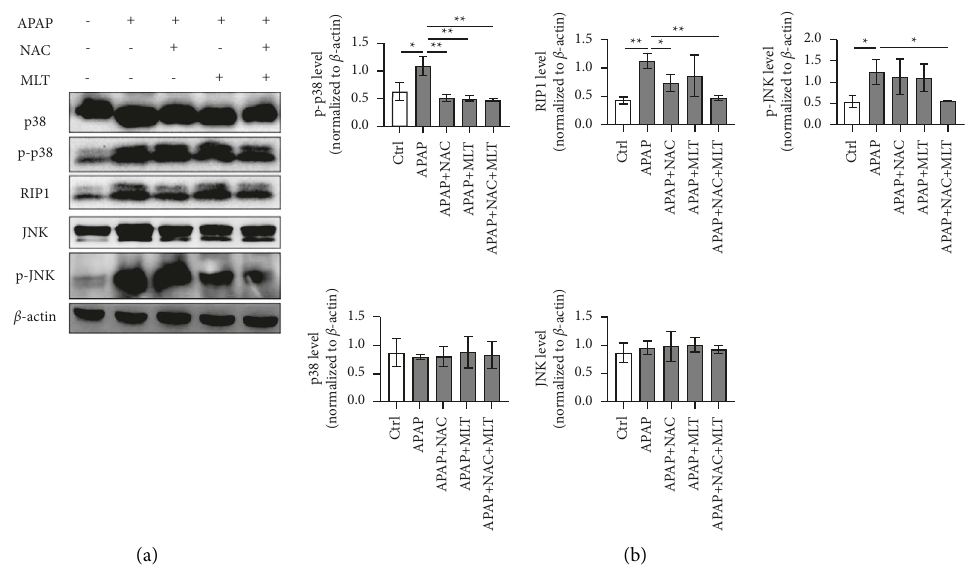
Figure 4: The effect of MLT, NAC, and combined drugs in RIP1/JNK associated apoptosis in APAP-induced liver damage. (a) Repre- sentative binds and (b) statistical grey-value analysis of protein level for each group. The columns are shown as means ± SD ( n � 3). ( ∗ p < 0 . 05, ∗∗ p < 0 . 01).